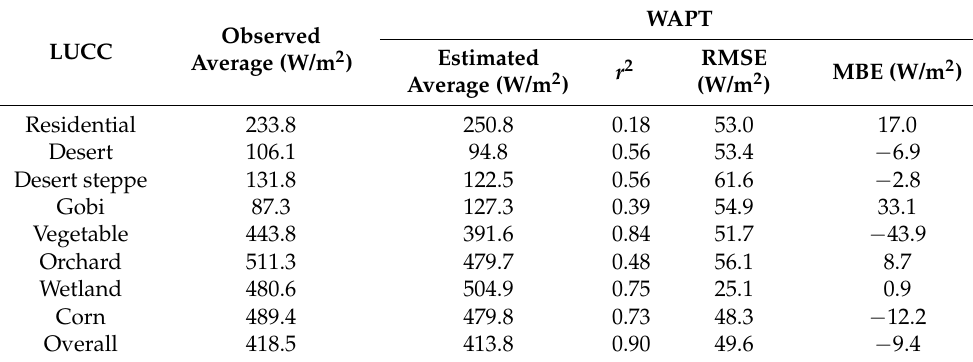
Table 5. Statistics of the modeling LE accuracies during months 6–9 in